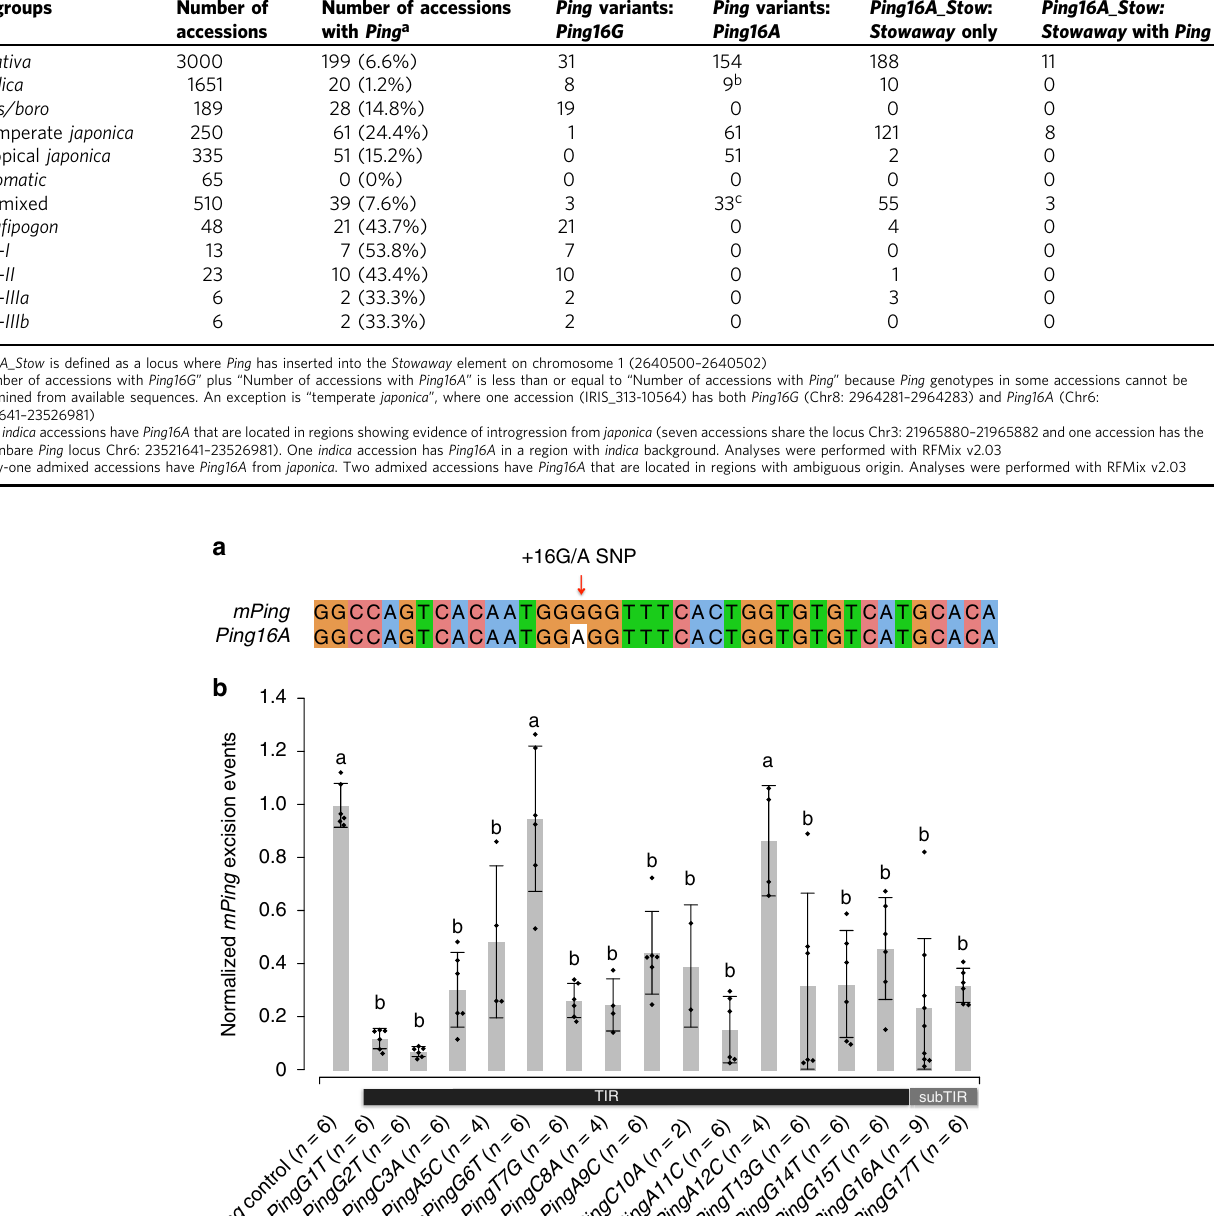
Ping variants: Ping variants: Ping16G Ping16A